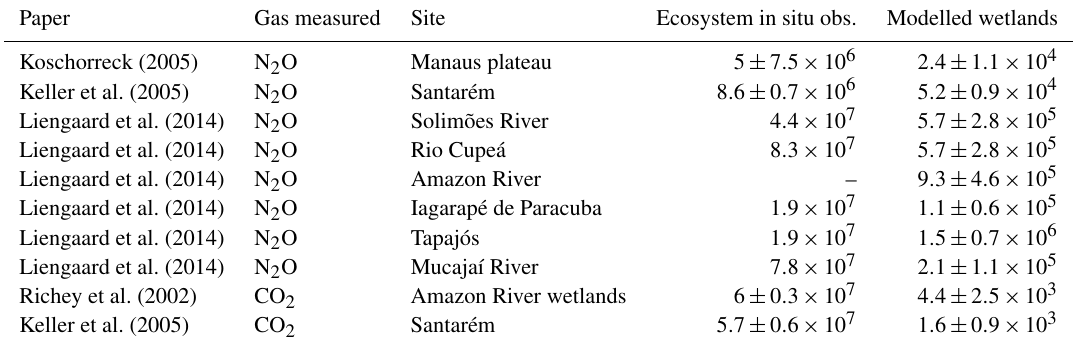
Table 4. Comparison of the values estimated by our study and the literature for emissions of CO 2 (gCkm − 2 yr − 1 ) and N 2 O (gNkm − 2 yr − 1 ).